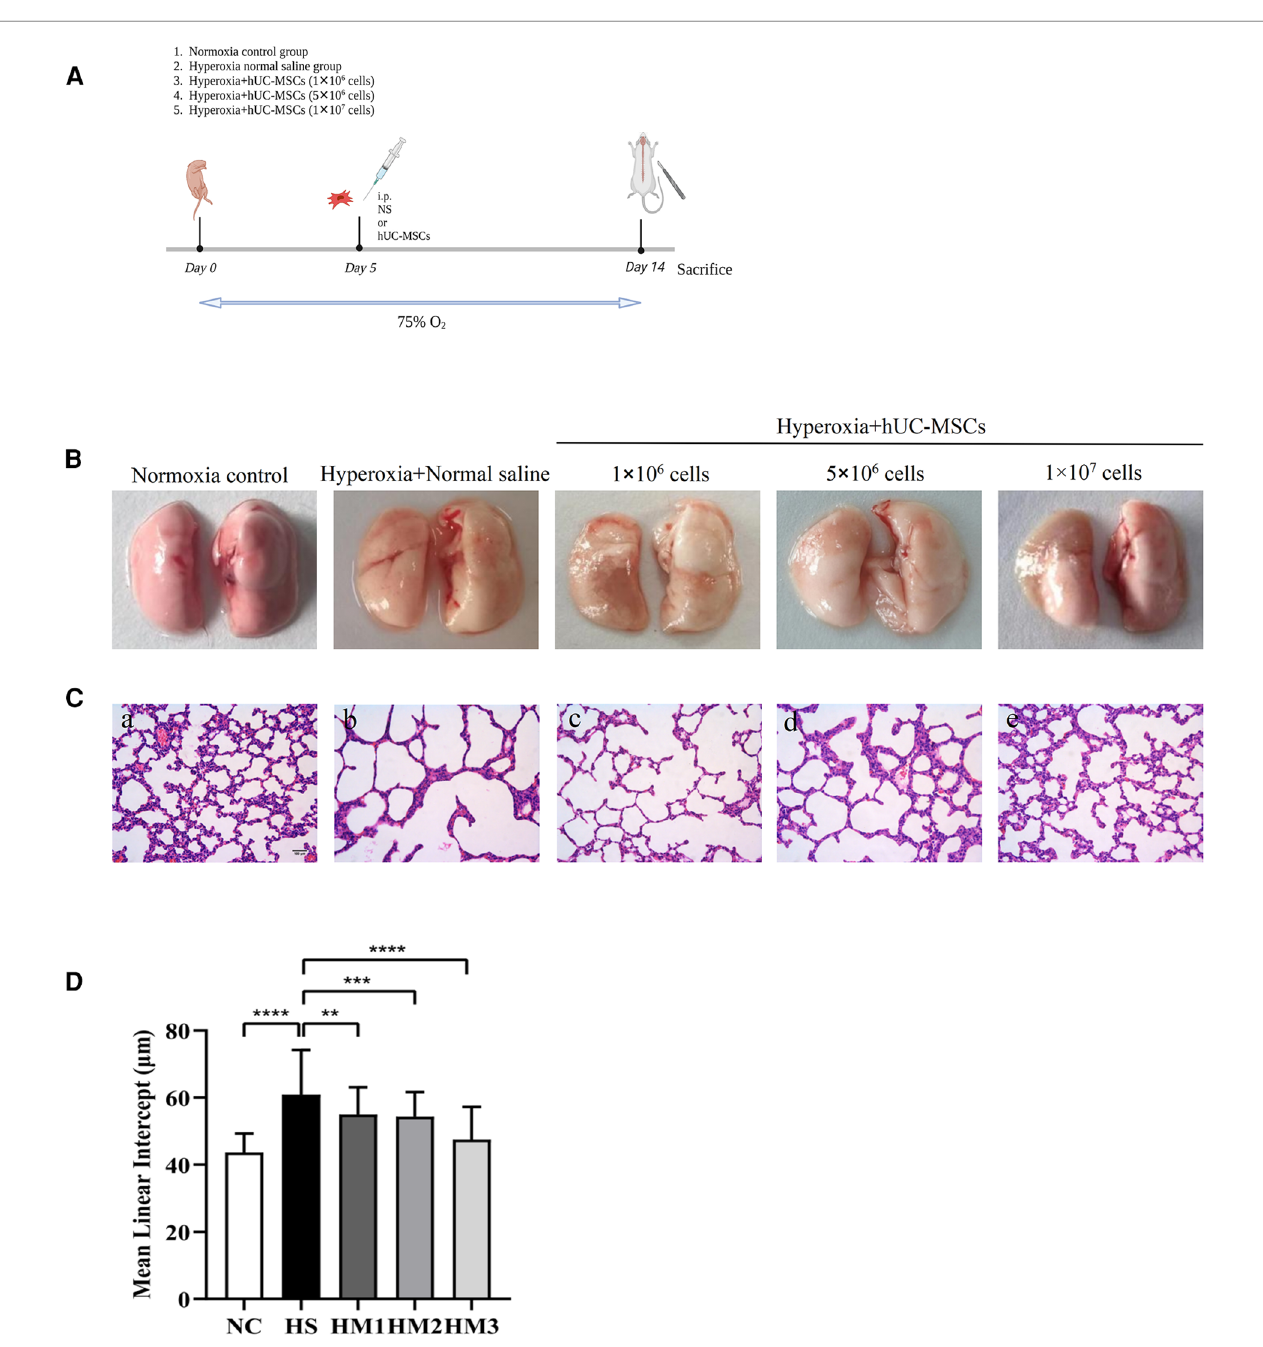
FIGURE 1 Human umbilical cord-derived mesenchymal stem cells (hUC-MSCs) restores hyperoxia-induced lung damages in bronchopulmonary dysplasia (BPD) of neonatal rats. ( A ) The schematic of hUC-MSCs procedure and study design; n =14 – 16 per group. ( B ) Representative images of whole lung from all groups at postnatal day (PN) 14. ( C ) The histology of the lung in different groups identi fi ed using haematoxylin-eosin (HE) staining. Magni fi cation, ×20 (scare bar =100 µm). At PN 14, the HS group (b) demonstrated fewer and larger alveoli and heterogenous alveolar sizes as compared to the NC group (a). hUC- MSCs (1×106 cells, 5×106 cells, or 1×107 cells) treatment improved hyperoxia-induced damages in alveolar growth and morphological changes in HM1 (c), HM2 (d), and HM3 (e), respectively, in a dose-dependent manner. ( D ) Mean linear intercept (MLI) in 14-day-old rat pups. The rat pups reared in the HS group showed a remarkably higher MLI than did those of the NC group. hUC-MSCs (1×10 6 cells, 5×10 6 cells, or 1×10 7 cells) remarkably reversed the hyperoxia-induced MLI increase. ** P <0.01, *** P <0.001, and **** P <0.0001. Data was presented as means±SEM, n =6 – 8 per